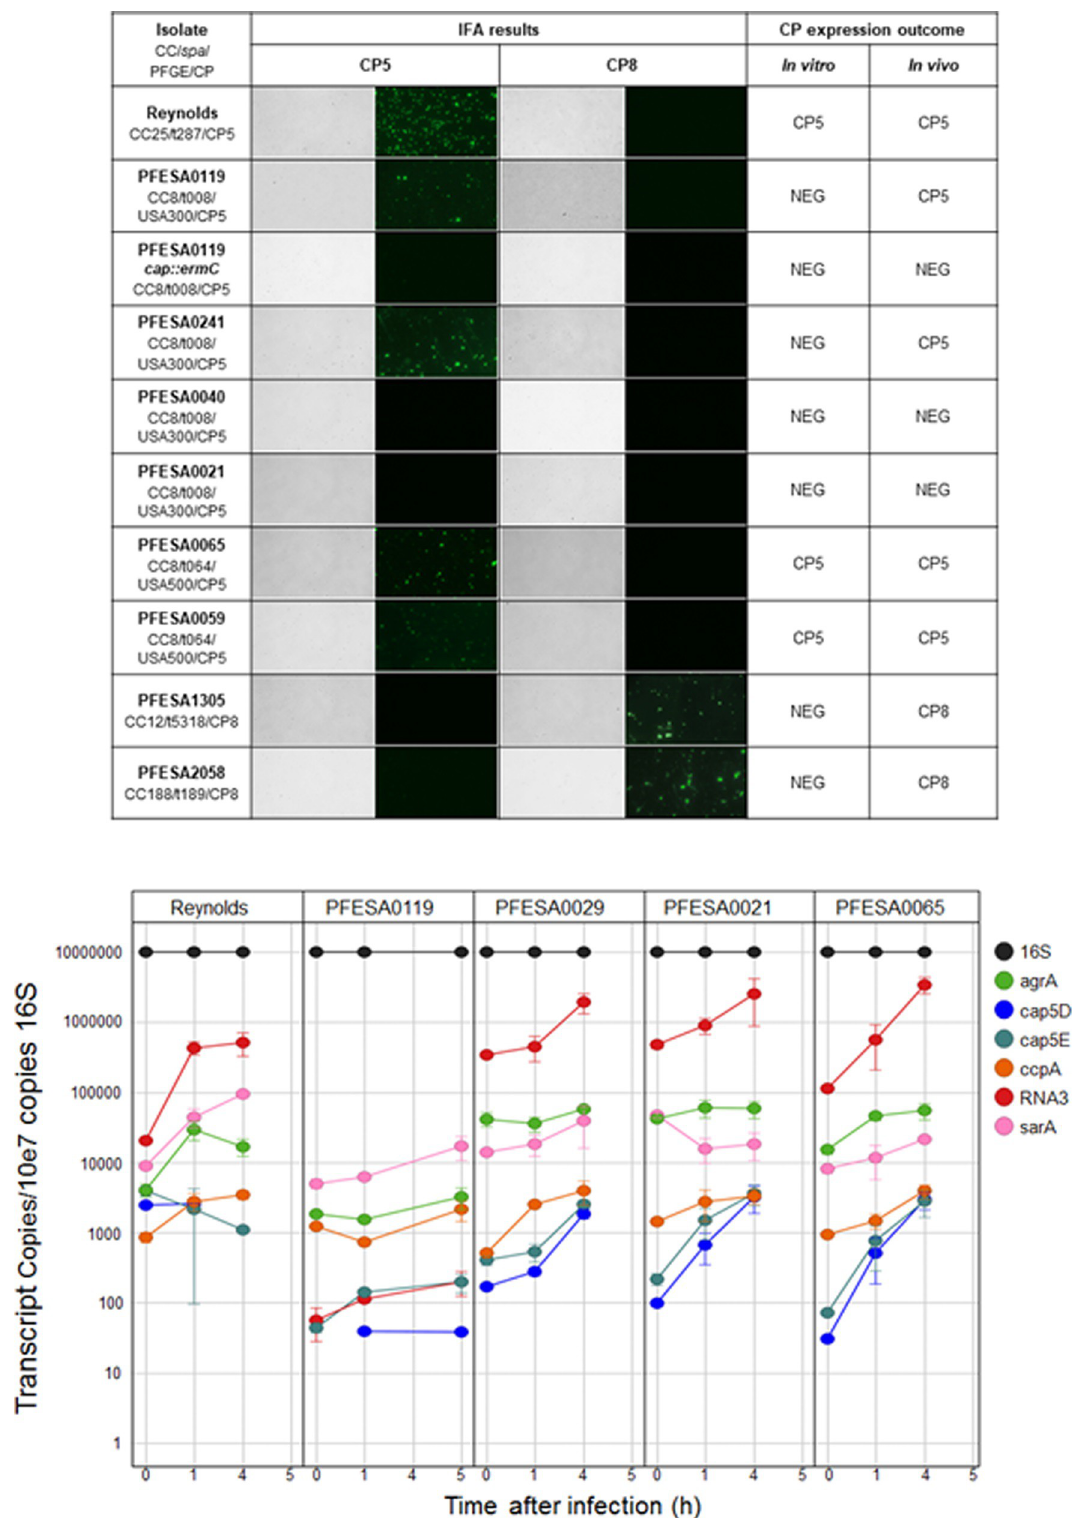
Fig 4. Detection of CP5 or CP8 polysaccharide expression in S . aureus isolates recovered from a murine bacteremia infection model. (A) Detection of surface polysaccharides in the murine IFA model. S . aureus was collected from the blood of infected mice